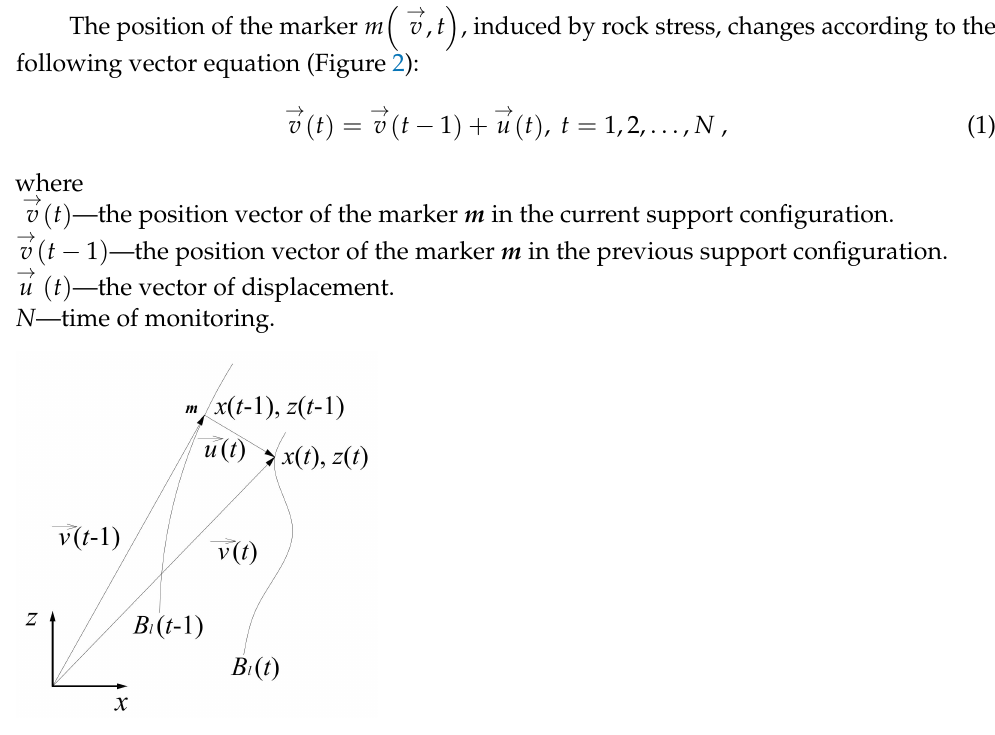
Figure 2. Change of the marker position over